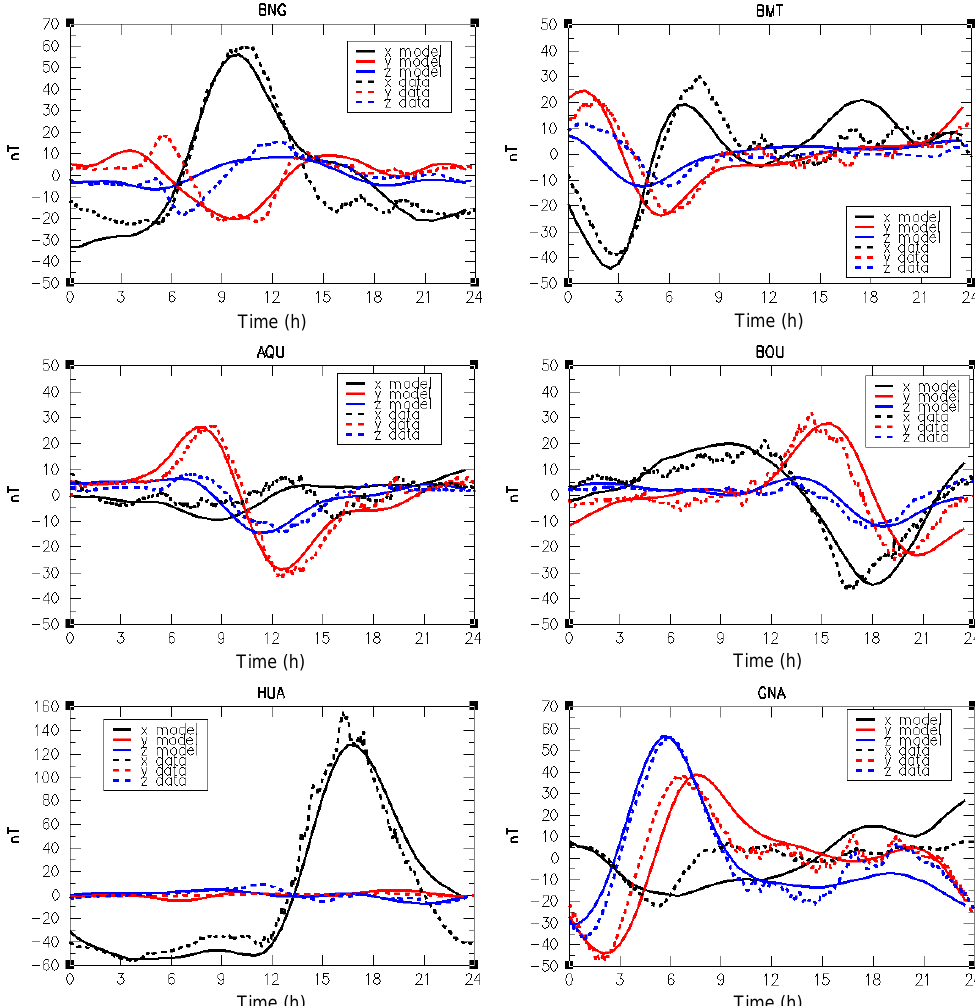
Figure 3. Quiet-time diurnal variation field comparison of the x (black), y (red), z (blue) components of the observatory station data (dashed line) and the CM4 (solid line). These are exemplar plots representative of the different geographical locations of the globe – BNG (Africa), BMT (Asia), AQU (Europe), BOU (North America), HUA (South America) and GNA